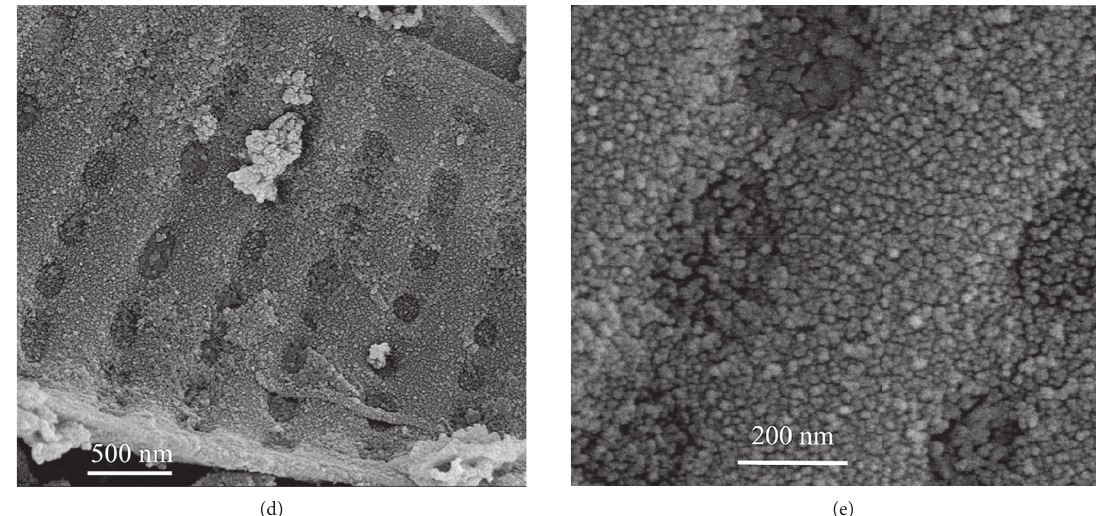
Figure 5: SEM images of (a) diatom frustules, (b) the external surface of diatom frustules, (c) the internal surface of diatom frustules, and (d) and (e) diatom frustule-TiO 2